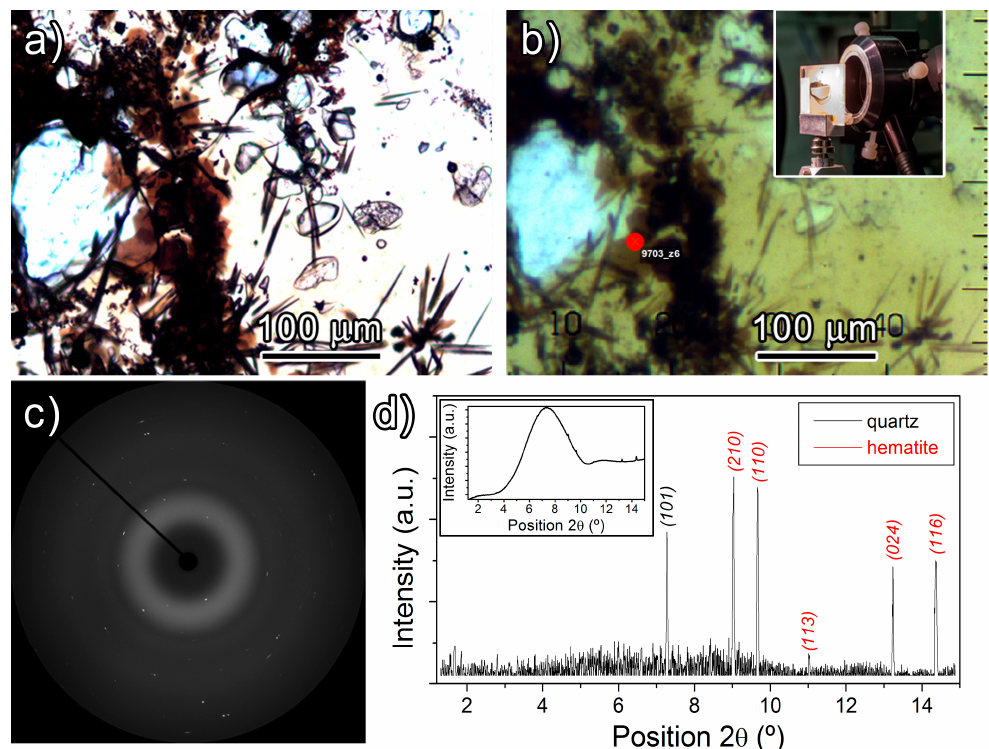
Figure 10. ( a ) A photomicrograph of a brown decoration from a ceramic glaze (TL). ( b ) The same image as Figure 10a taken from the camera coupled to the micro-diffraction apparatus at ALBA Synchrotron Facility: the red dot represents the beam spot size (approx. 15 μ m); the inset shows the camera and sample holder showing a mounted thin section. ( c ) The sum of several 2-D diffraction frames obtained at the point defined by the red dot in Figure 10b. ( d ) The diffraction pattern obtained from the 2-D diffraction frames after the removal of the background: the diffraction peaks have been indexed according to the quartz and hematite structures; the inset is the raw diffraction pattern without the removal of the background.